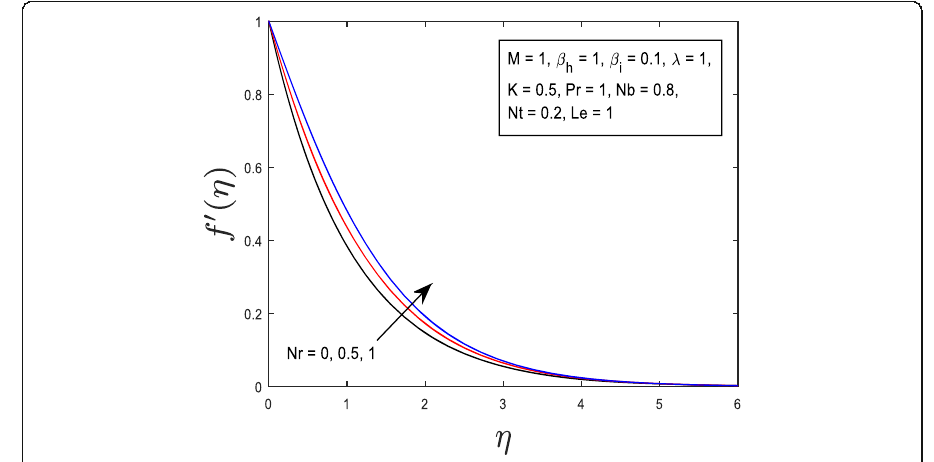
Fig. 15 Graph of velocity for various values of Nr